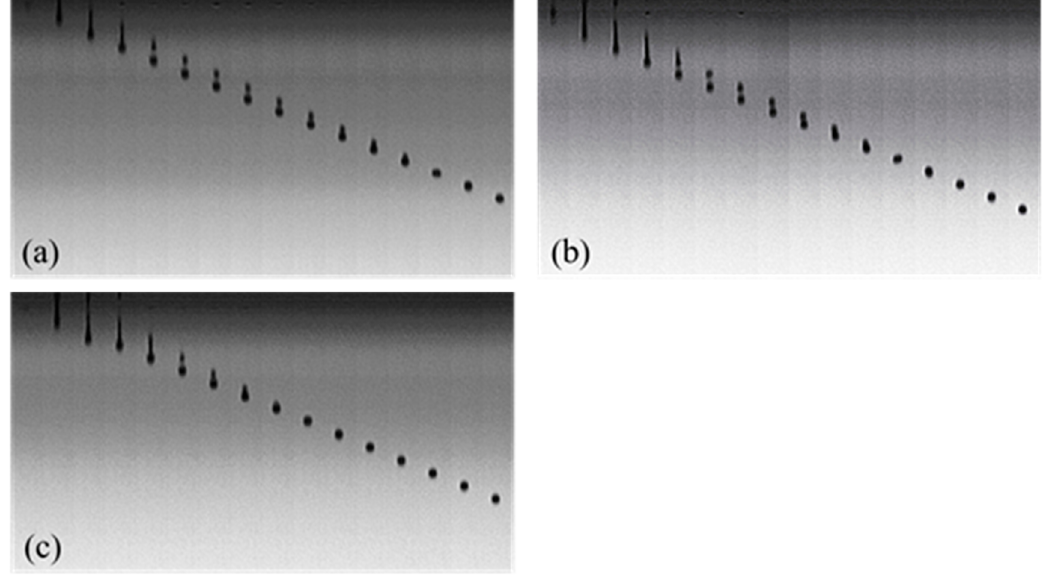
Figure 10. The influence of PEG molecular weights on the droplet formation of Red 218 dye solutions. ( a ) PEG200; ( b ) PEG400; ( c ) PEG600.The concentrations of Red 218 and PEG were 7% and 30%, respectively, the temperature was 25 °C, and the jet frequency was 10,000 Hz.